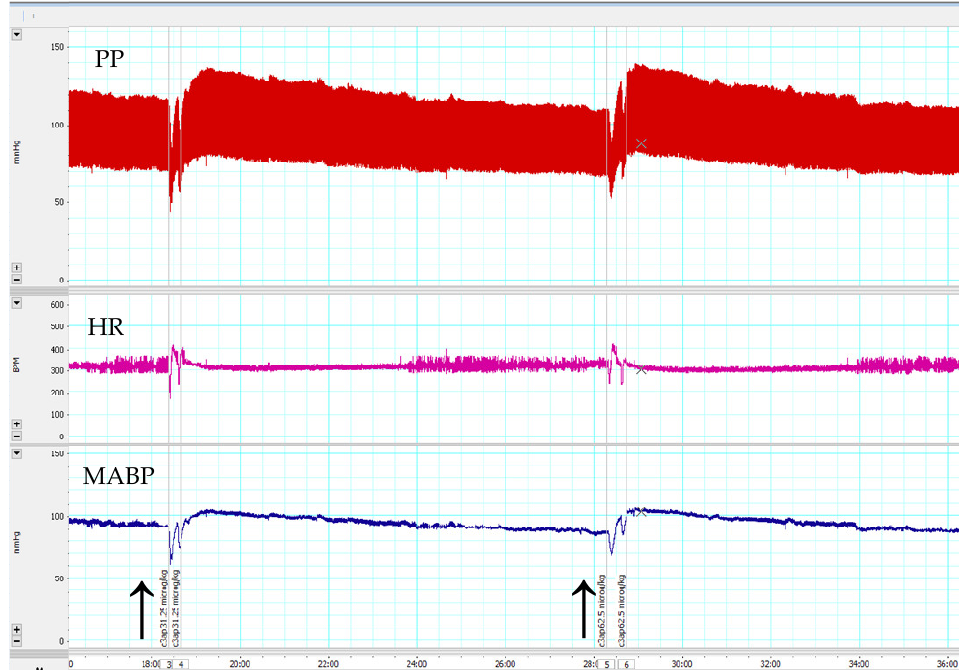
Figure 3. An original recording of effects of C3a (63–77) peptide at 31.25 and 62.5 µg/kg bolus i.v. doses on blood pressure and heart rate in anesthetized C57Bl/6n mice. Arrows indicate the time of C3a (63–77) peptide administrations. Upper chart : pulsatile blood pressure (PP); Middle chart : heart rate (HR); Lower chart : mean arterial blood pressure (MABP). C3a (63–77) peptide caused a transient increase in MABP and HR.